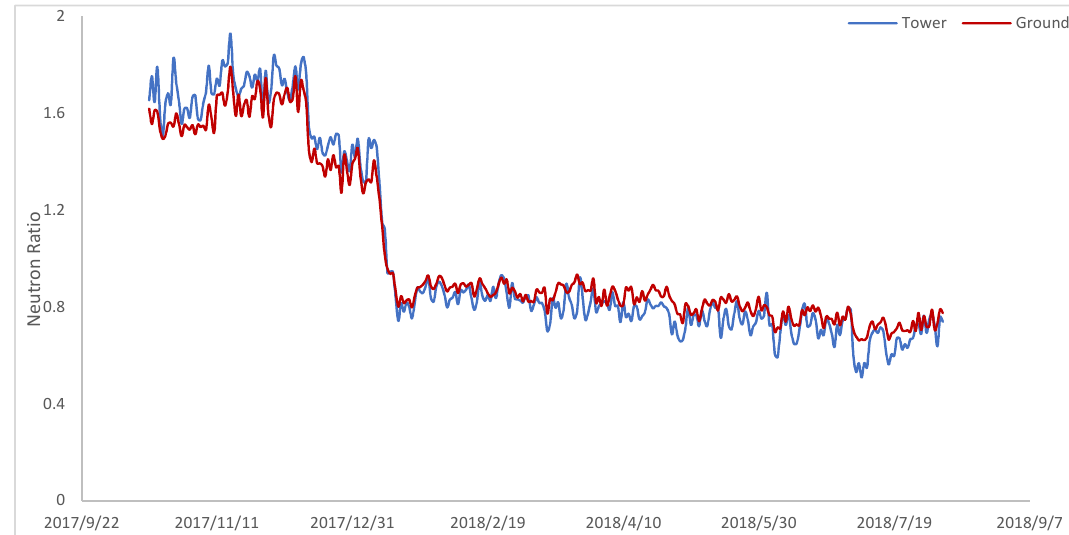
Figure 8. Daily neutron ratio (thermal/epithermal) of the tower CRNS and ground CRNS in the Two-Streams Catchment from October 2017 to August 2018.